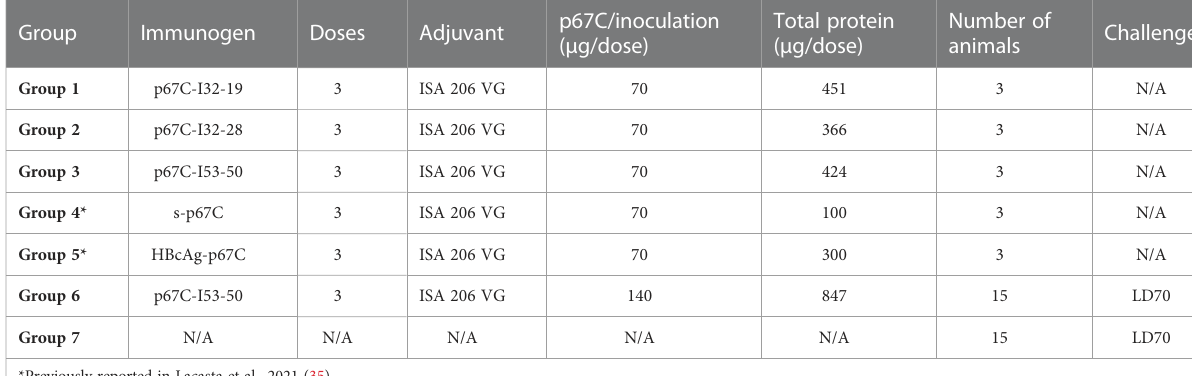
TABLE 1 Summary of immunogenicity and challenge experiment animal groups and immunogens.